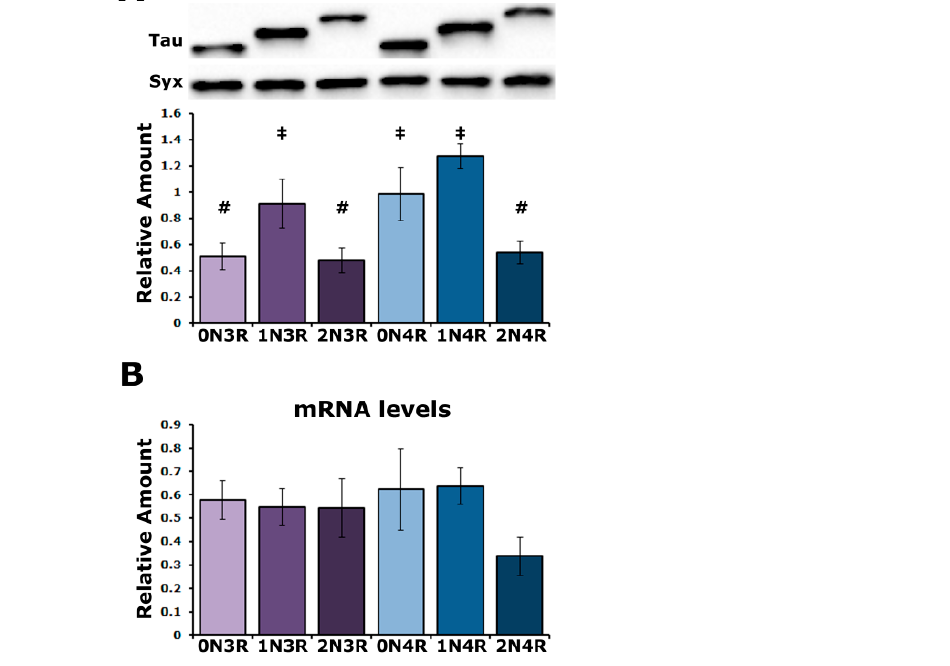
Figure 1. Variable levels of hTau isoforms in the Drosophila CNS. ( A ) A representative Western blot of head lysates from animals expressing the different hTau transgenes under the elavGAL4 driver detected with the 5A6 anti-tau antibody. The hTau isoform expressed in the fly CNS is indicated below the quantification. For the quantification, hTau levels were normalized using the Syx loading control and are shown as the mean ± SEM of n = 3 independent experiments. Bars marked with # are not significantly different from each other but are from those marked with ‡ and conversely ‡ marked bars are not significantly different from each other but are from ones marked with #. ( B ) Quantification of tau mRNA levels by Reverse Transcription followed by the Polymerase Chain Reaction in the CNS of flies expressing the indicated hTau transgenes under elavGAL4. The rp49 RNA served as an internal reference transcript for the reaction and has been used to normalize the quantifications. Bars indicate mean ± SEM relative mRNA levels. n = 4. Statistical details for both experiments are presented in Supplemental Table